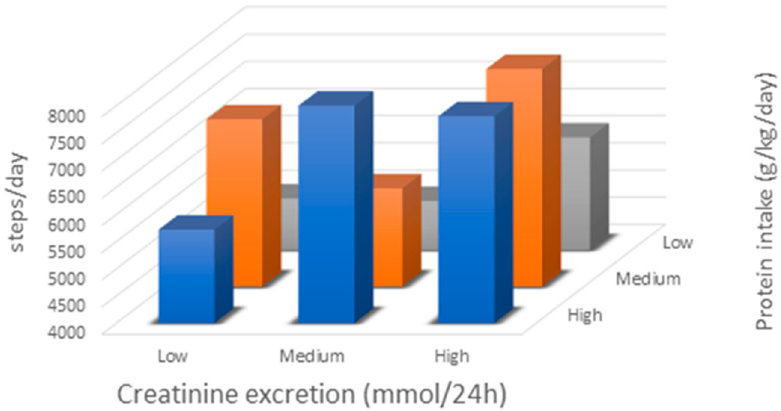
Figure 2. Low, medium, and high represent the lowest, middle, and highest tertiles of protein intake and creatinine excretion. The figure shows the interaction between urinary creatinine excretion (CER) and protein intake on total steps per day. Both high CER and high protein intake were associated with more steps / day, and total steps per day was highest in those with both high CER and high protein intake.